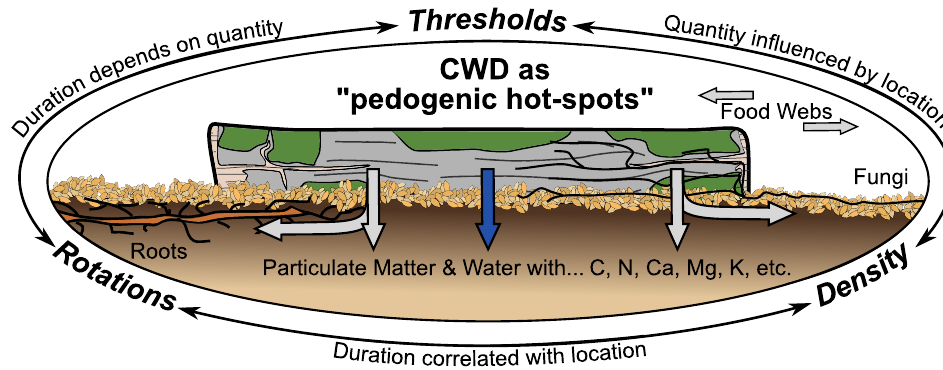
Figure 2. Coarse woody debris (CWD) are concentrated centers of biogeochemical and -physical processes in space and time—i.e., “pedogenic hot-spots”—which have larger effects on forest and soil ecosystems through roots, fungi, and other biological networks. Minimum thresholds, rotation cycles, and spatial densities are potential management parameters, but specifics are unknown and